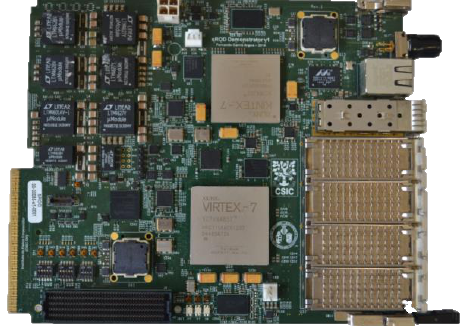
Fig. 5. Picture of the double AMC Tile PreProcessor Demonstrator [10].